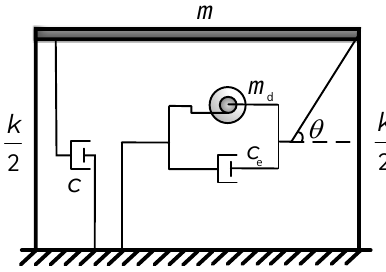
Figure 12. Simplified analytical model of the CBIS-equipped SDOF structure.